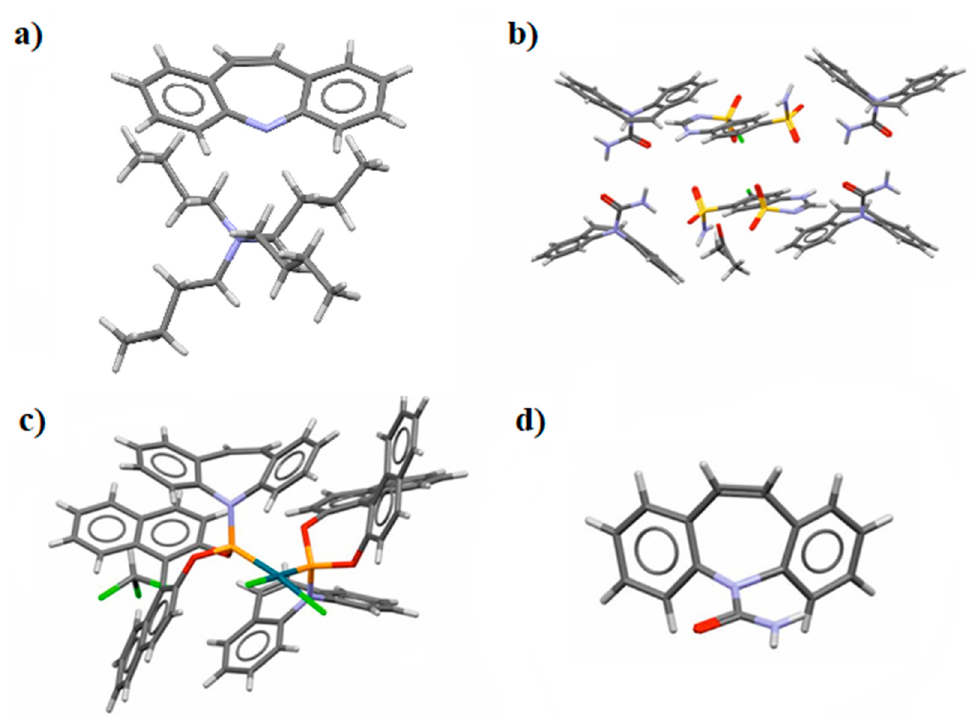
Figure 6. 5 H -dibenzo[b,f]azepine derivatives with the highest and the lowest HOMED values for the middle ring: YIJPEM [62] (0.8217) ( a ), VEJZUI [64] (0.7934) ( b ), YIFCUM [65] ( − 0.1731) ( c ), HEMRIB [63] ( − 0.2506) ( d ). In parentheses are given the HOMED values for the middle ring.